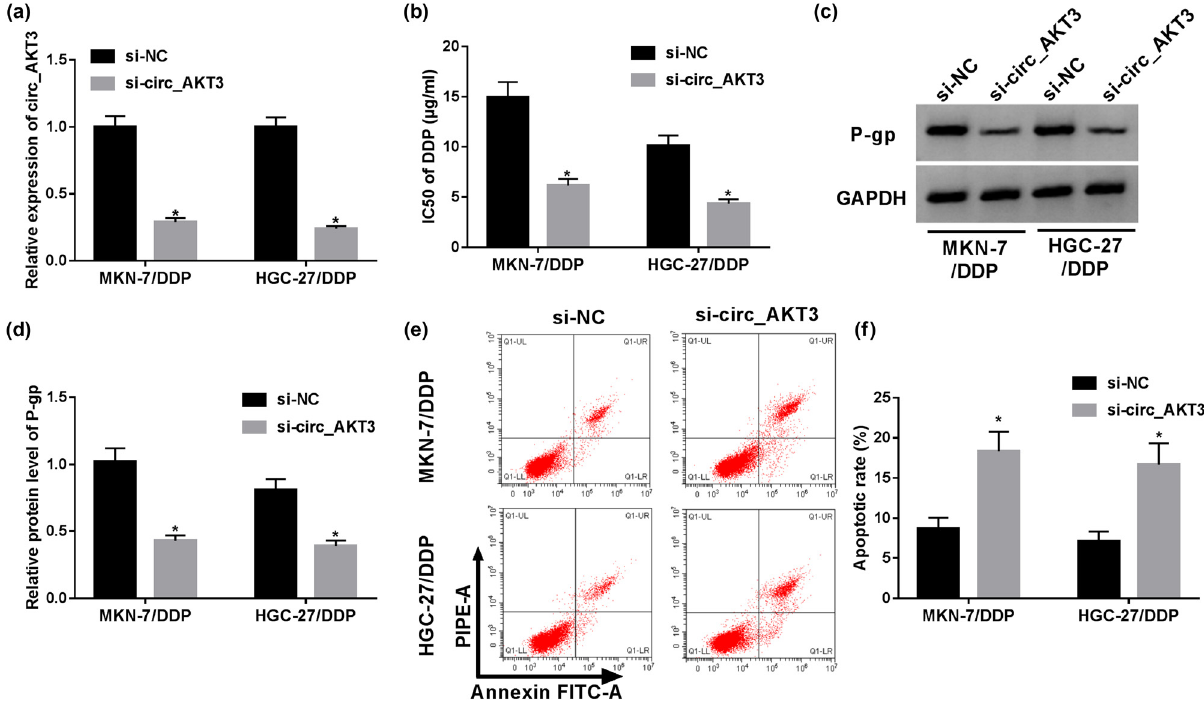
Figure 2: Silence of circ_AKT3 inhibits cisplatin resistance of resistant GC cells. MKN - 7/DDP and HGC - 27/DDP cells were transfected with si - circ_AKT3 or s - NC. Then, circ_AKT3 expression ( a ) , IC 50 of cisplatin ( b ) , P - gp protein level ( c and d ) and apoptosis ( e and f ) were measured via RT - qPCR, MTT, Western blot and fl ow cytometry, respectively. * P <